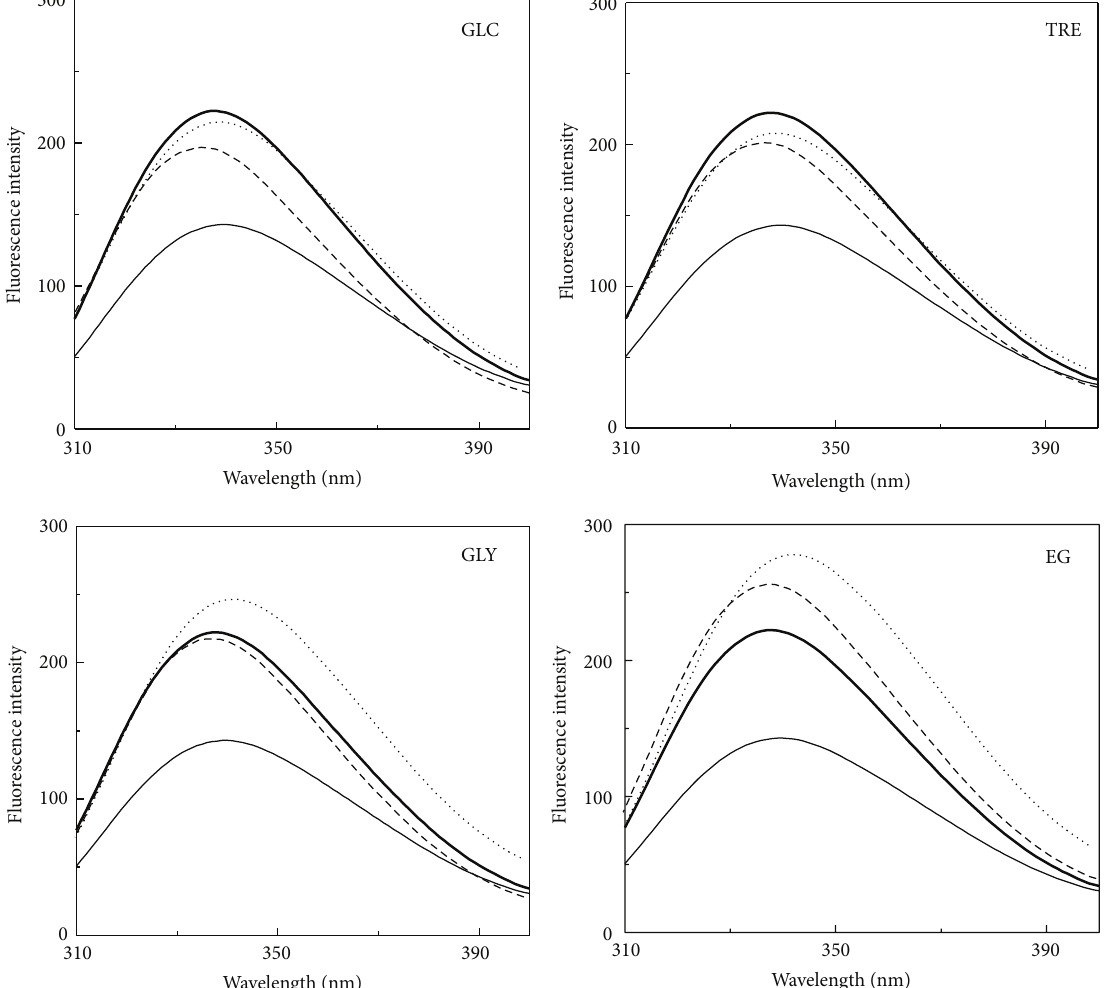
Figure 2: Effect of various polyols, such as, glucose (GLC), trehalose (TRE), glycerol (GLY), and ethylene glycol (EG), on the tryptophan fluorescence spectra of the native and the acid-denatured GAs. Different line symbols represent native GA (thick curve), acid-denatured GA (thin curve), native GA + polyol (dashed curve), and acid-denatured GA + polyol (dotted curve). The spectra were recorded at 25 ∘ C using a protein concentration of 0.12 𝜇 M. Different polyol concentrations used were 2.6 M GLC, 1.3M TRE, 8.0 M GLY, and 8.0 M EG.